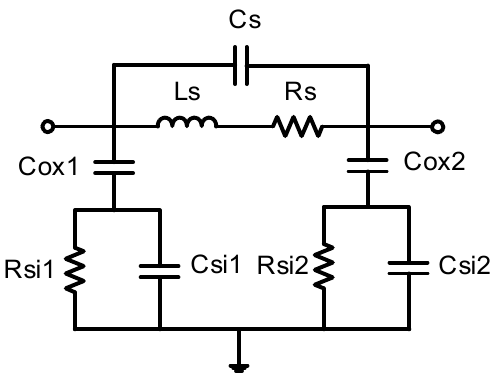
Figure 4. Equivalent circuit of the planar spiral inductor.